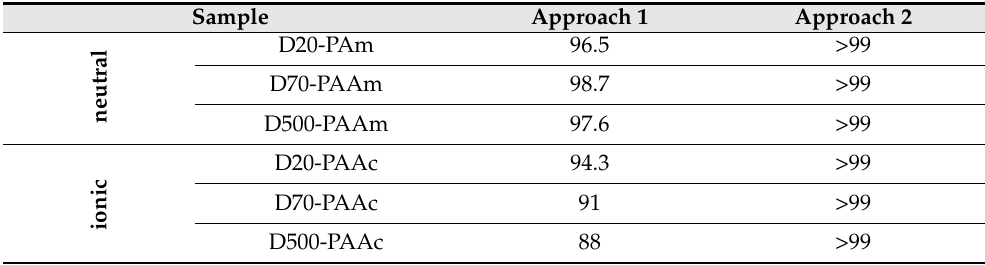
Table 1. Uranium uptake (%) from water solution by star-like polyacrylamides in two different approaches